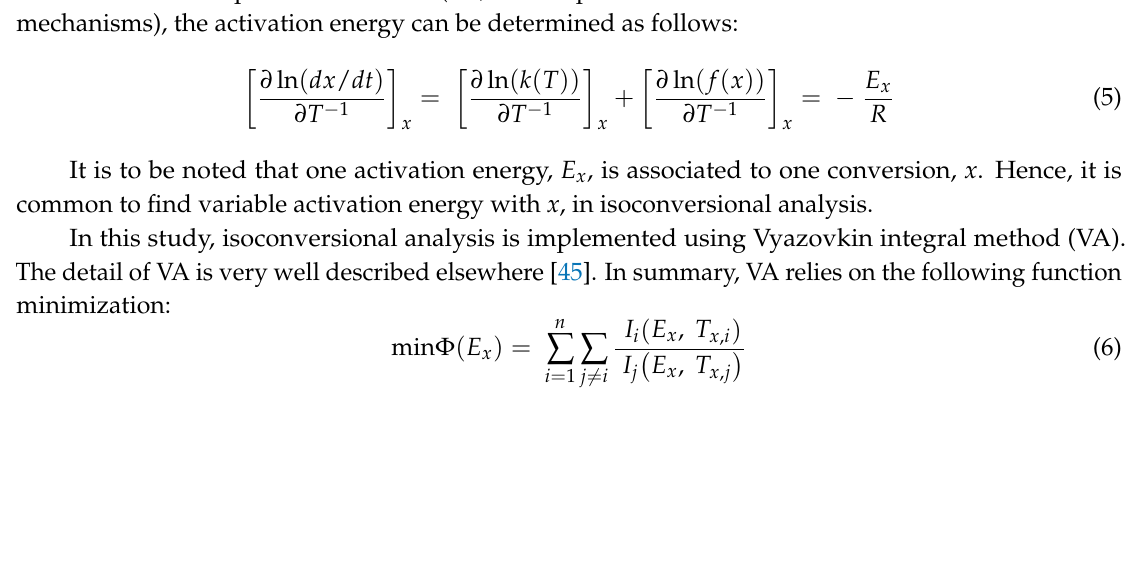
Figure 4. Nonisothermal kinetic profiles of PMO, CHO, and MCHO at 3, 5, 8 and 10 °C/min.